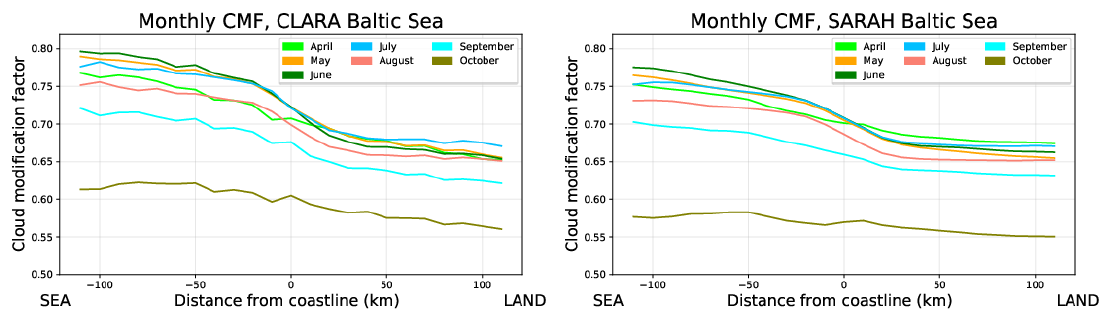
Figure 4. Climatological monthly Cloud Modification Factor (CMF) as a function of distance to the coastline for CLARA-A2 ( left panel) and SARAH-2 ( right